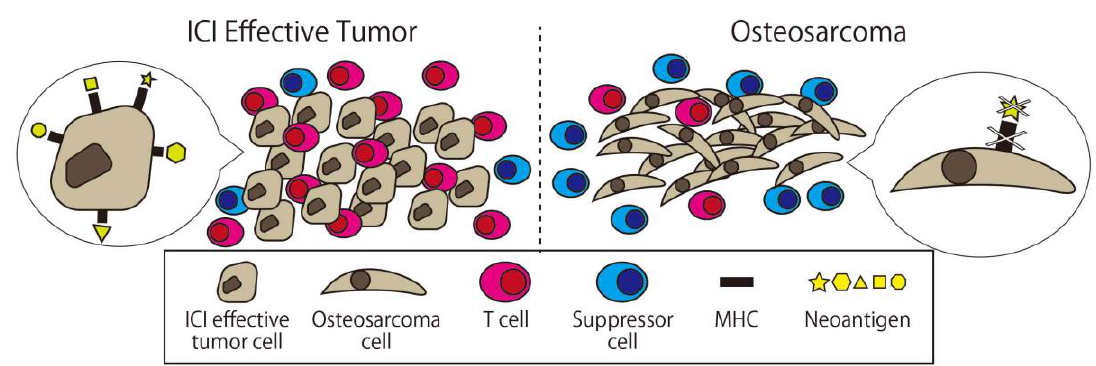
Figure 5. Comparison between osteosarcoma and ICI effective tumor cells. There are fewer immune cells and more suppressors cell in osteosarcoma, and there is less expression of major histocompatibility complex (MHC) and neoantigen on the surface of osteosarcoma.